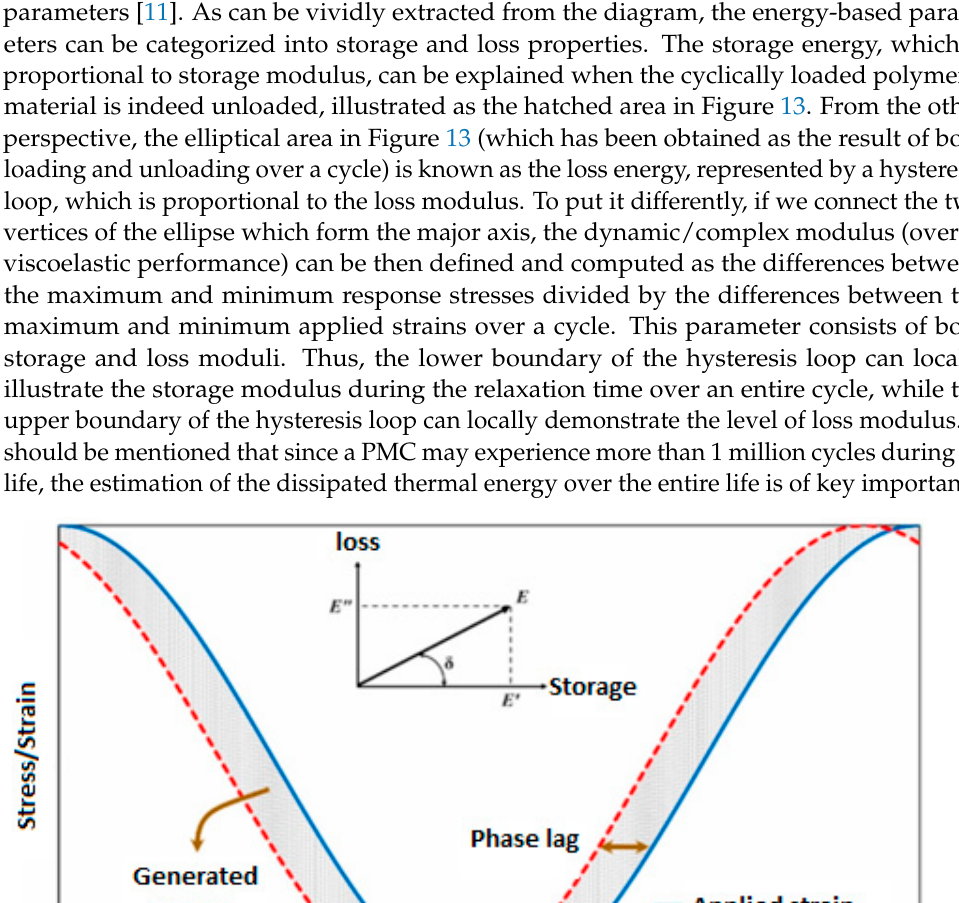
Figure 13. Schematic representation of the generated hysteresis loop and energy-based parameters. From the thermodynamics point of view, by taking into account the self-heating ef- fect in PMC structures, the generated energy ( gen q ) over a fatigue cycle can be calculated